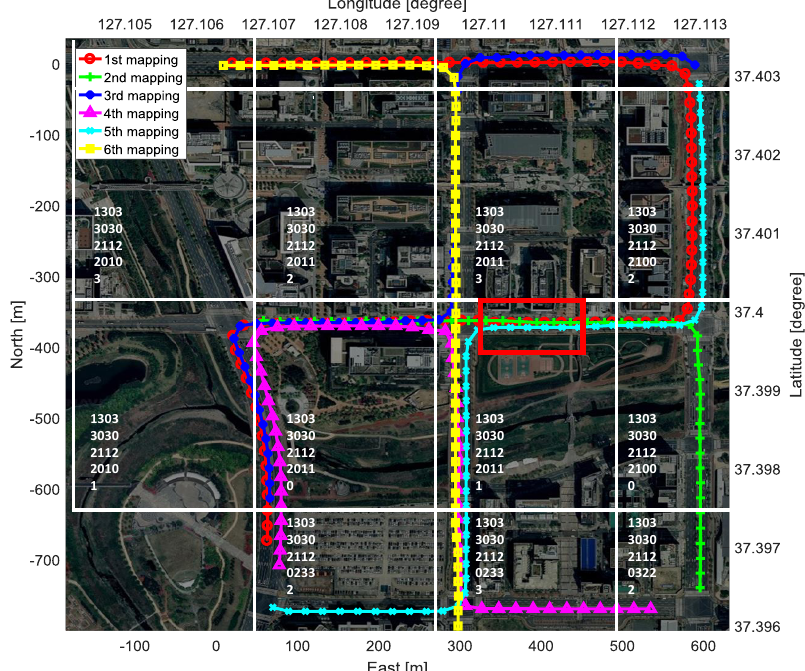
Figure 10. Trajectories and quad-tree tiles for the six test driving at different times in an urban area.